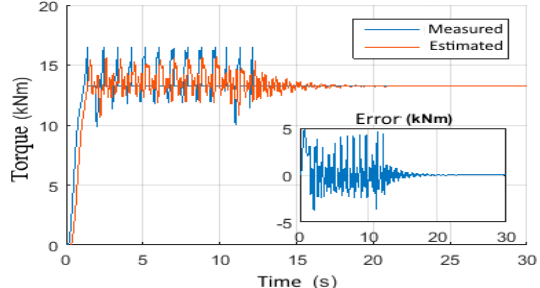
Figure 14. Measured and estimated Toque on bit by H ∞ observer.